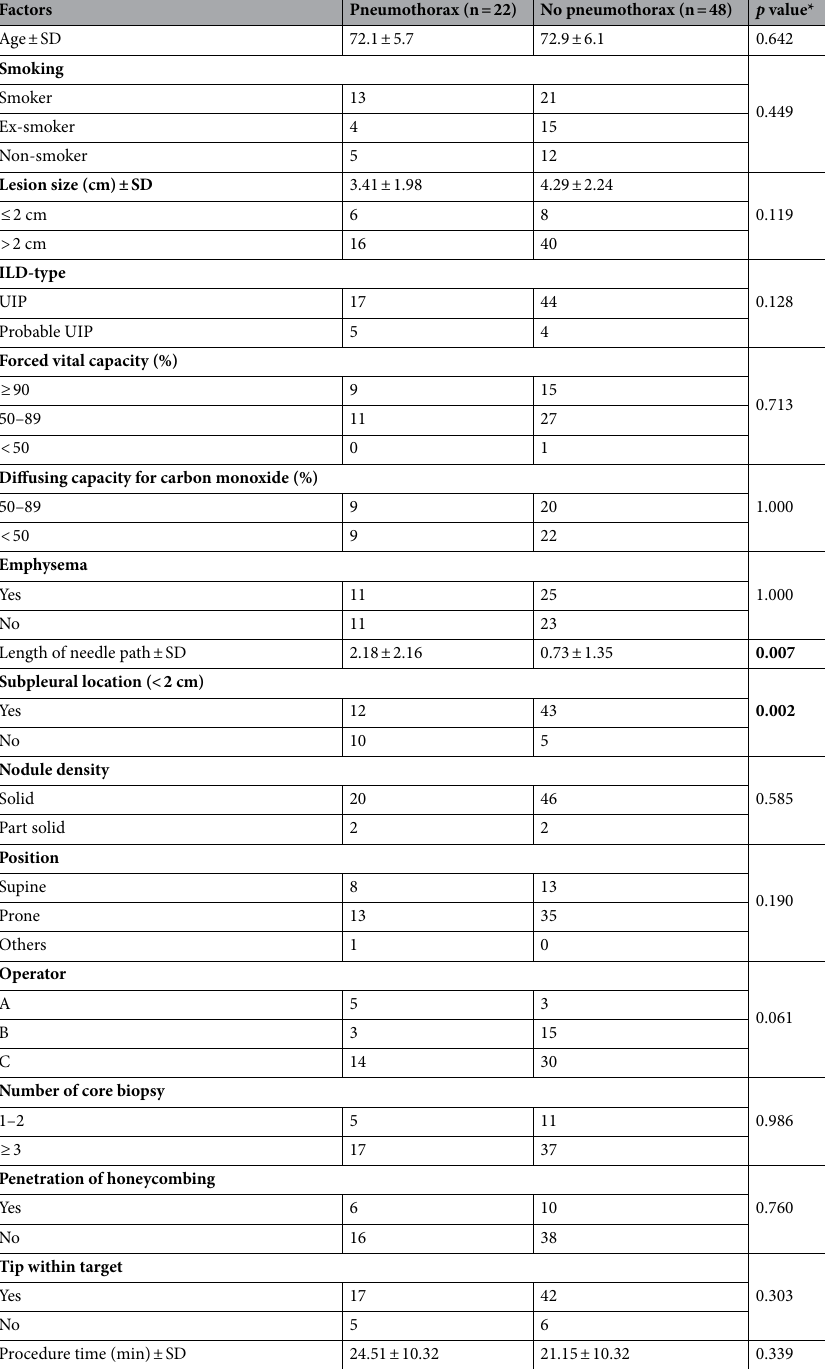
Table 4. Risk factors for pneumothorax. * p value of Pearson χ 2 test or Fisher’s exact test for categorical variables and Student’s t-test for continuous variables. SD standard deviation. Significant values are in